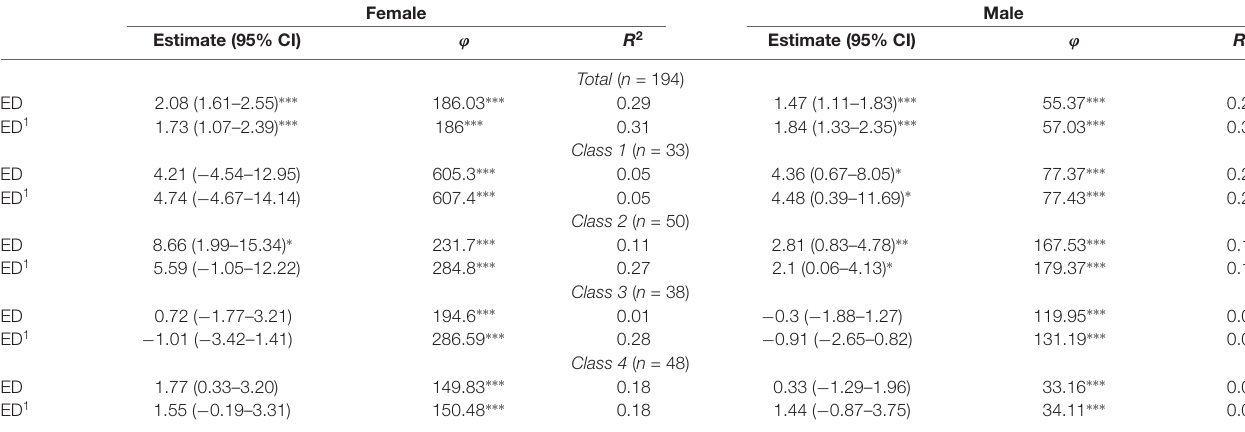
TABLE 3 | Beta regression analyses for the relationship between alcohol dependence and early drinking (ED) for all countries and each country class by gender. Female Estimate (95%